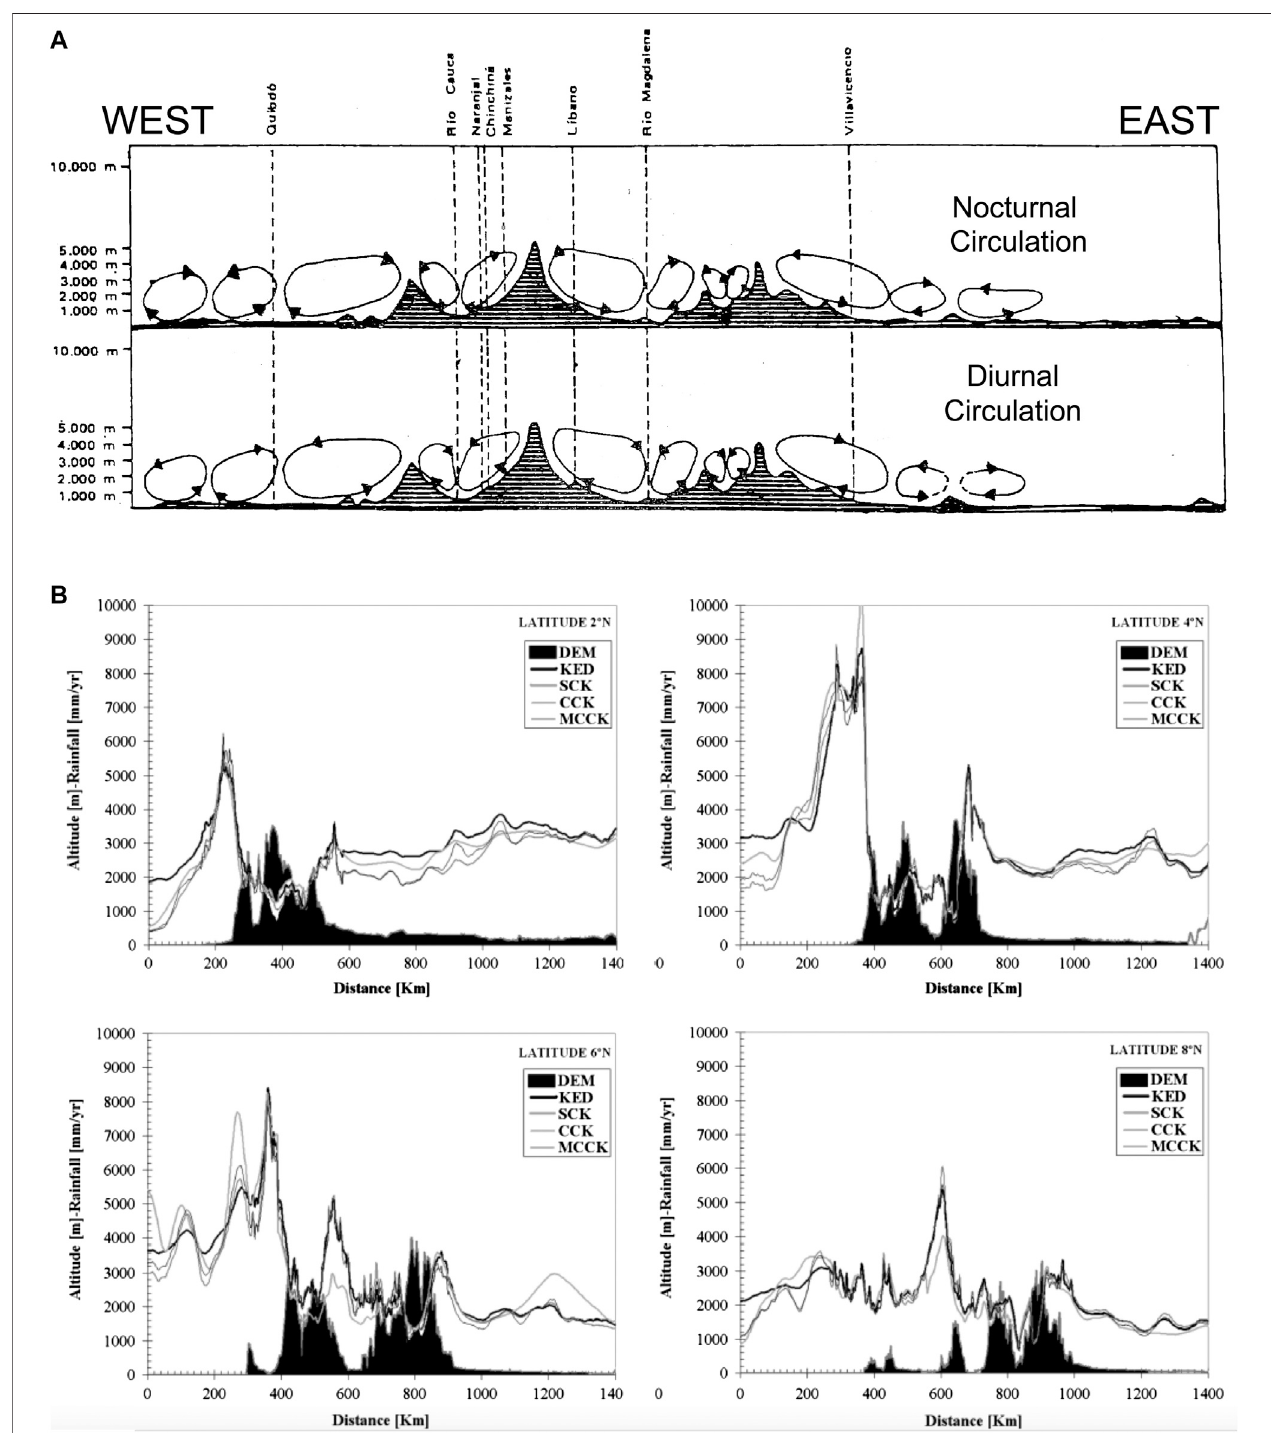
FIGURE 3 | (A) Schematics of local wind circulations among the intra-Andean valleys of the three ranges of the Colombian Andes during night (top) and day (bottom) . Adapted from Oster (1979). (B) Distribution of the long-term mean annual rainfall along four transects (2 ° N, 4 ° N, 6 ° N, 8 ° N) covering the three ranges of the Colombian Andes ( fi lled in black), showing the location of the pluviometric optima in the intra-Andean valleys. Results were obtained using diverse variants of Kriging interpolation at 4-km resolution for all Colombia, denoted with different line types, with information from 1,180 rain gauges covering the period 1950 – 2005, and satellite data from the tropical rainfall measuring mission (TRMM) for the period 1999 – 2005. Source: Alvarez-Villa et al. (2011).